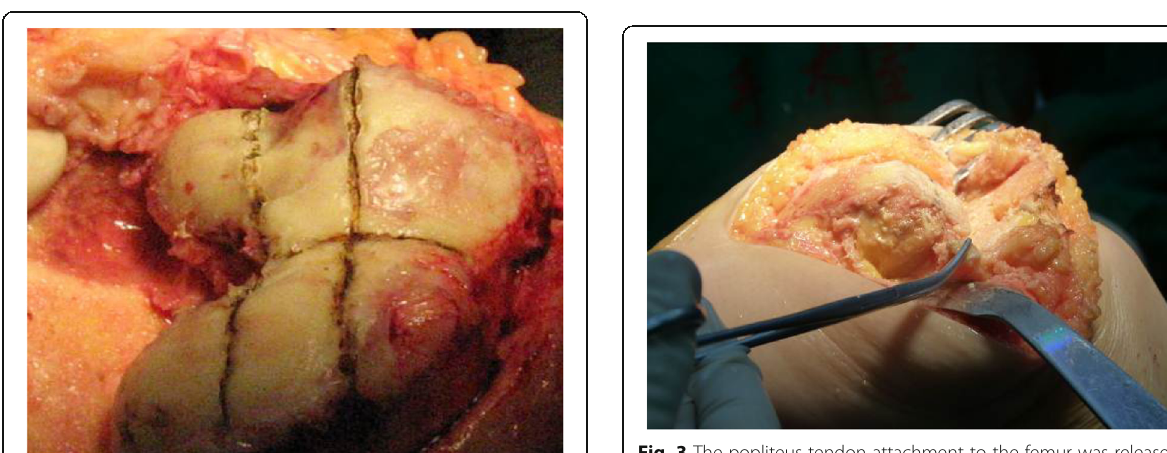
Fig. 3 The popliteus tendon attachment to the femur was released when the lateral tightness correlated with internal rotational